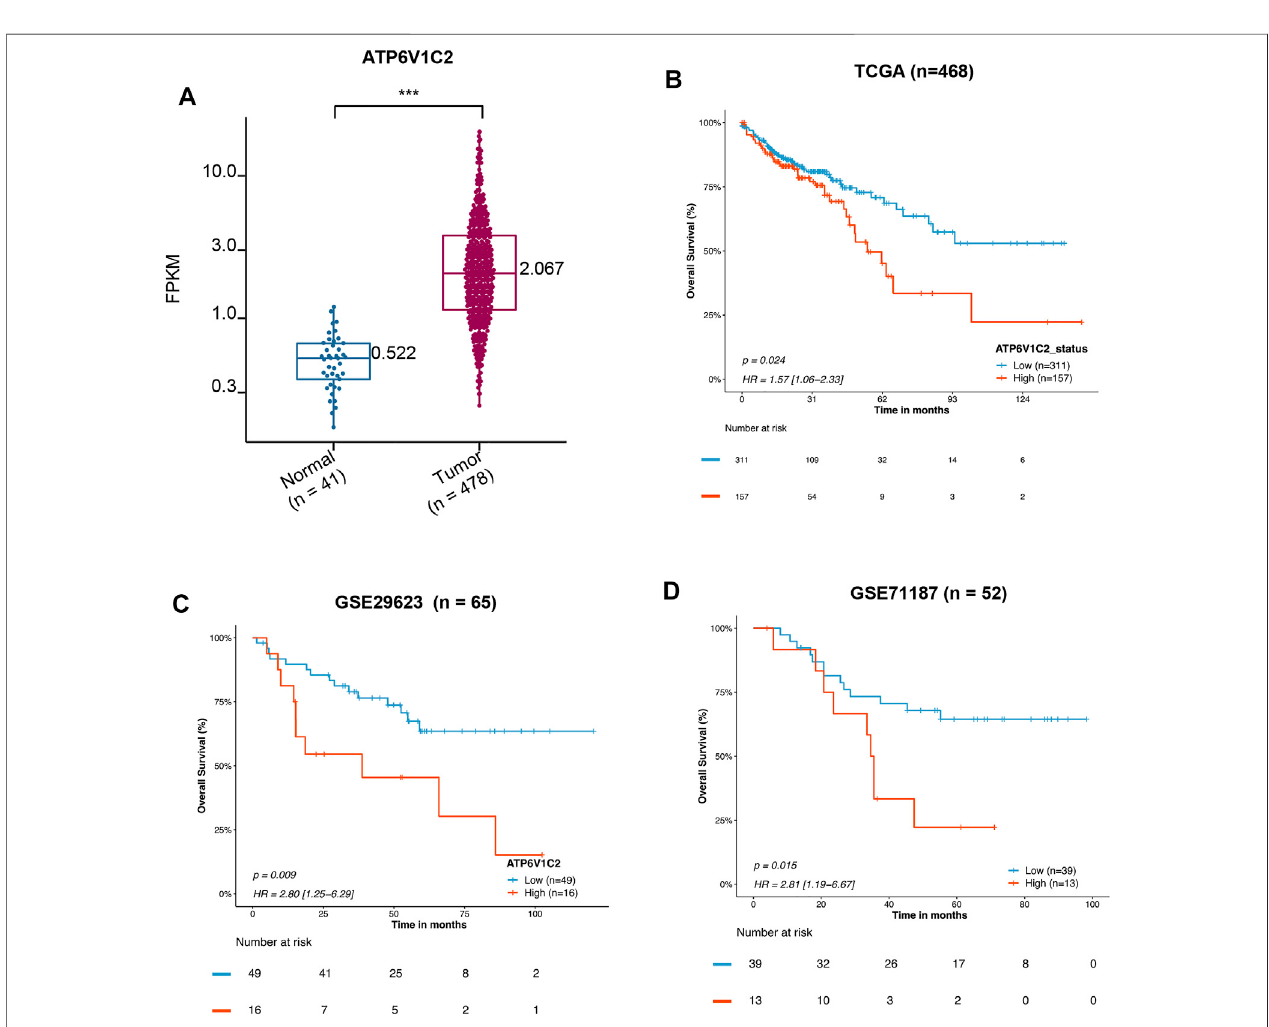
FIGURE1| Prognostic valueofmRNAexpression ofATP6V1C2 inCOADpatients. (A) Thedifference inATP6V1C2 expression levelbetweenCOADand adjacent non-cancerous tissues based on TCGA COAD dataset; (B) Kaplan – Meier survival curves of overall survival (OS) based on the ATP6V1C2-high and -low groups expression in TCGA-COAD dataset; (C) Survival curves of OS based on the ATP6V1C2-high and -low groups expression in GSE29523 dataset; (D) Survival curves of OS based on the ATP6V1C2-high and -low groups expression in GSE71187 dataset. COAD: colon adenocarcinoma; TCGA: The Cancer Genome Atlas. *** indicates p < 0.001, statistical analysis was performed using two-tailed Student ’ s t